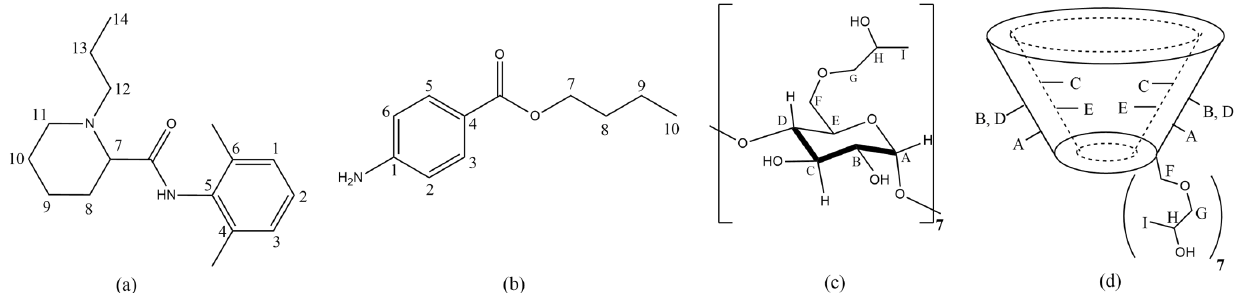
Figure 2. Structures of the molecules of ( a ) RVC; ( b ) BTB; ( c , d ) HP- β CD. A small variation in the chemical shift of BTB in the inclusion complexes can be seen in Table 1. Variations of − 0.12 for H3 and H5 in the BTB/HP- β CD and of − 0.02 for H2 and H6 complex for BTB/HP- β CD/SL complex is also present. To prove the for- mation of the BTB/HP- β CD/SL complex encapsulation, efficiency tests of BTB were per- formed. EE values were found from 81.1% for the BTB/SL complex, and 84.2% for BTB/HP- β CD/SL; these values show that BTB is mostly encapsulated. According to the literature [29,30], the aromatic ring is expected in the cavity of the carrier, and interac- tions of the aromatic rings of BTB and RVC in the cavity of HP- β CD were observed. Table 1. Attribution and chemical displacement of the 1 H of BTB and 1 H of RVC and HP- β CD in the binary and ternary complexes.